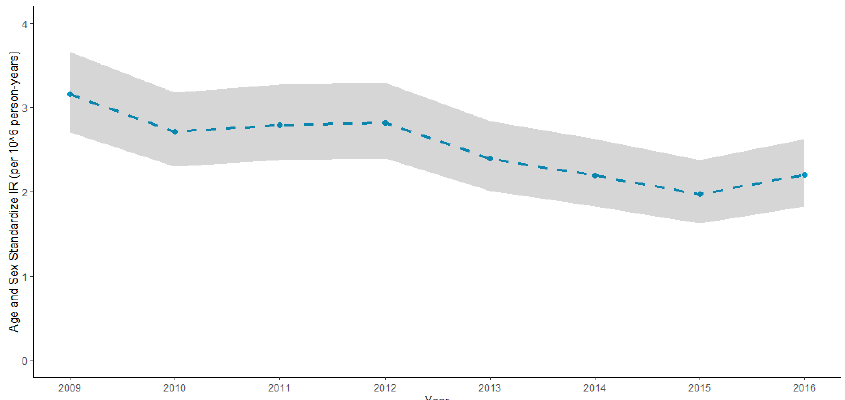
Figure 1. Year-specific VL standardized incidence rates between 2009 and 2016. Age and sex standardized IR are expressed per 10 6 person-years and were computed with direct standardization using the Italian census data of 2011 as reference population. Estimates are represented as dashed lines, while the 95% CI bands are represented as shaded areas.